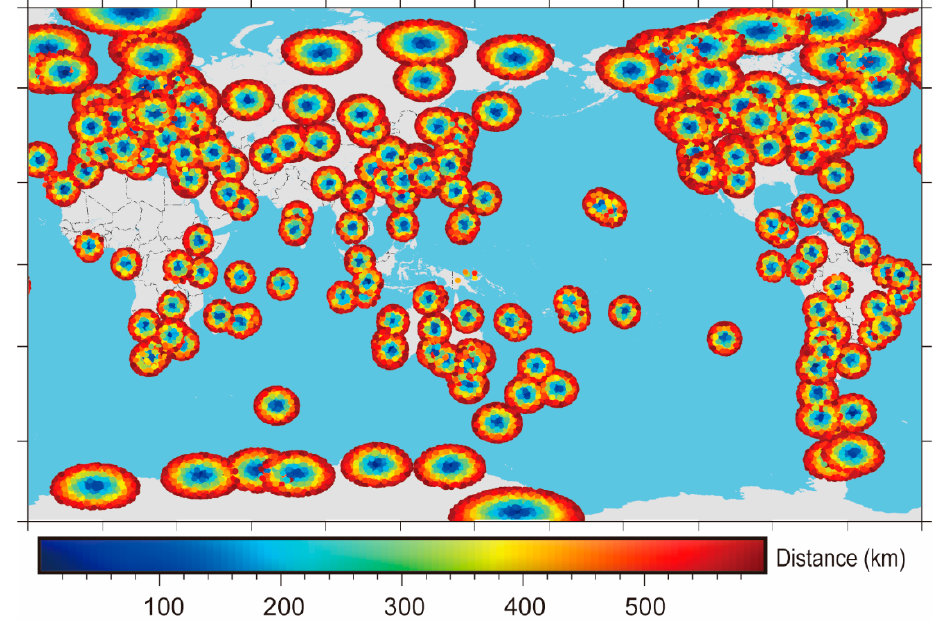
Figure 4. Horizontal distance distribution of gnsZTD matched with atmPrf in 2008.